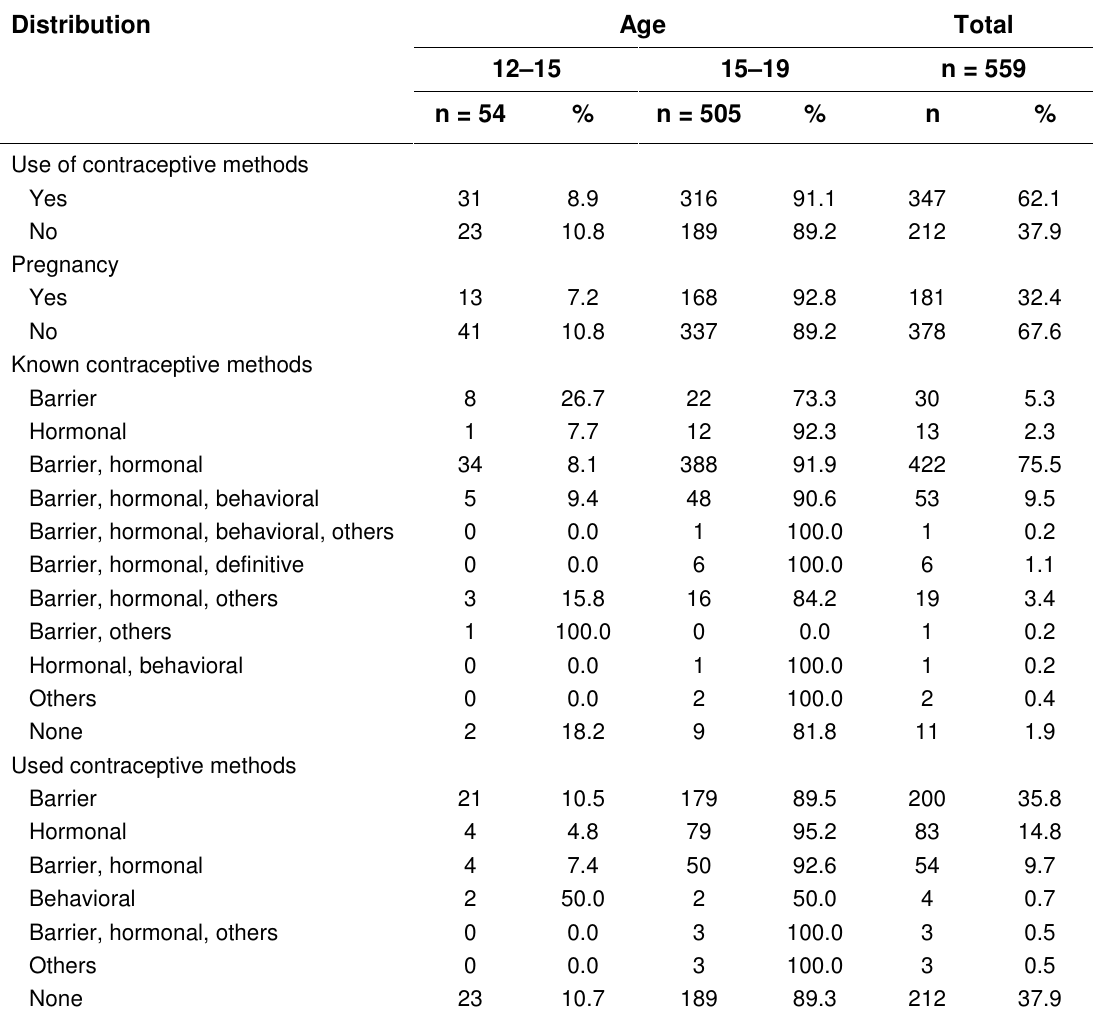
Distribution of the Adolescents with an Active Sexual Life According to Knowledge, Use of Contraceptive Methods, and